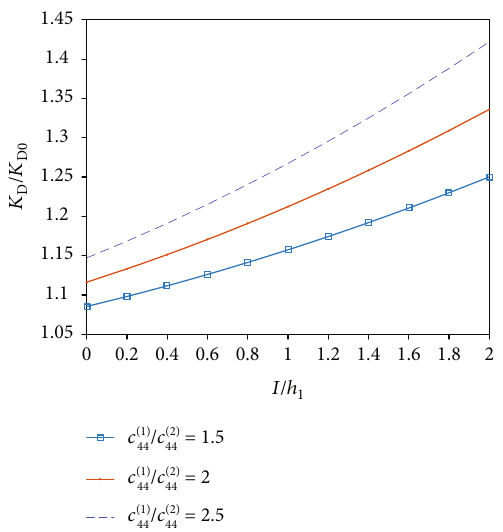
Figure 5: E ff ects of l / h di ff erent c